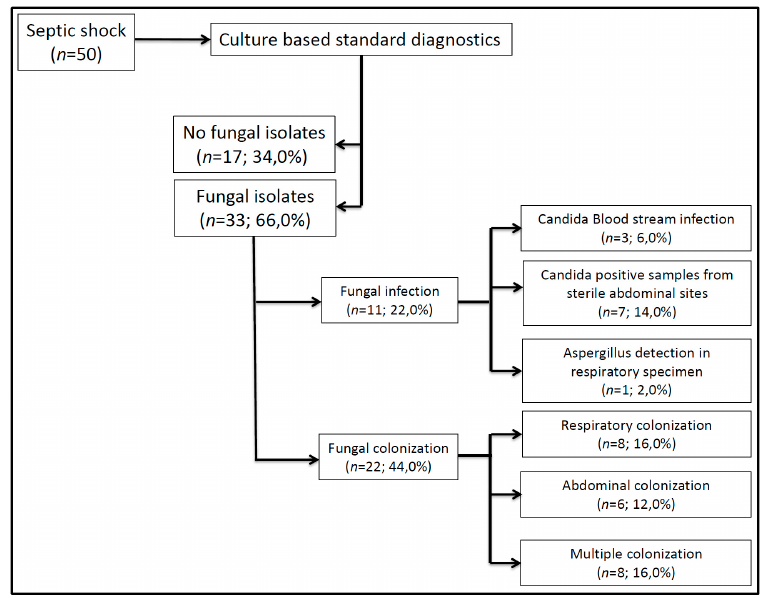
Figure 1. Identification of fungal pathogens in patients with septic shock ( n = 50).